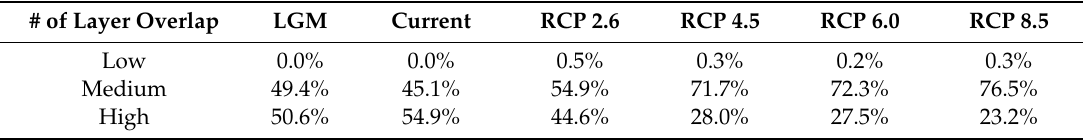
Table 6. Predicted changes in the percent of climatically suitable habitat for T. c. carolina using hotspot maps based on the number of environmental predictor layers that overlap with one another. We classified low overlap (0–2 layers), medium overlap (3–4), and high overlap (5–6). Abbreviations: Last Glacial Maximum (LGM) and Representative Concentration Pathway